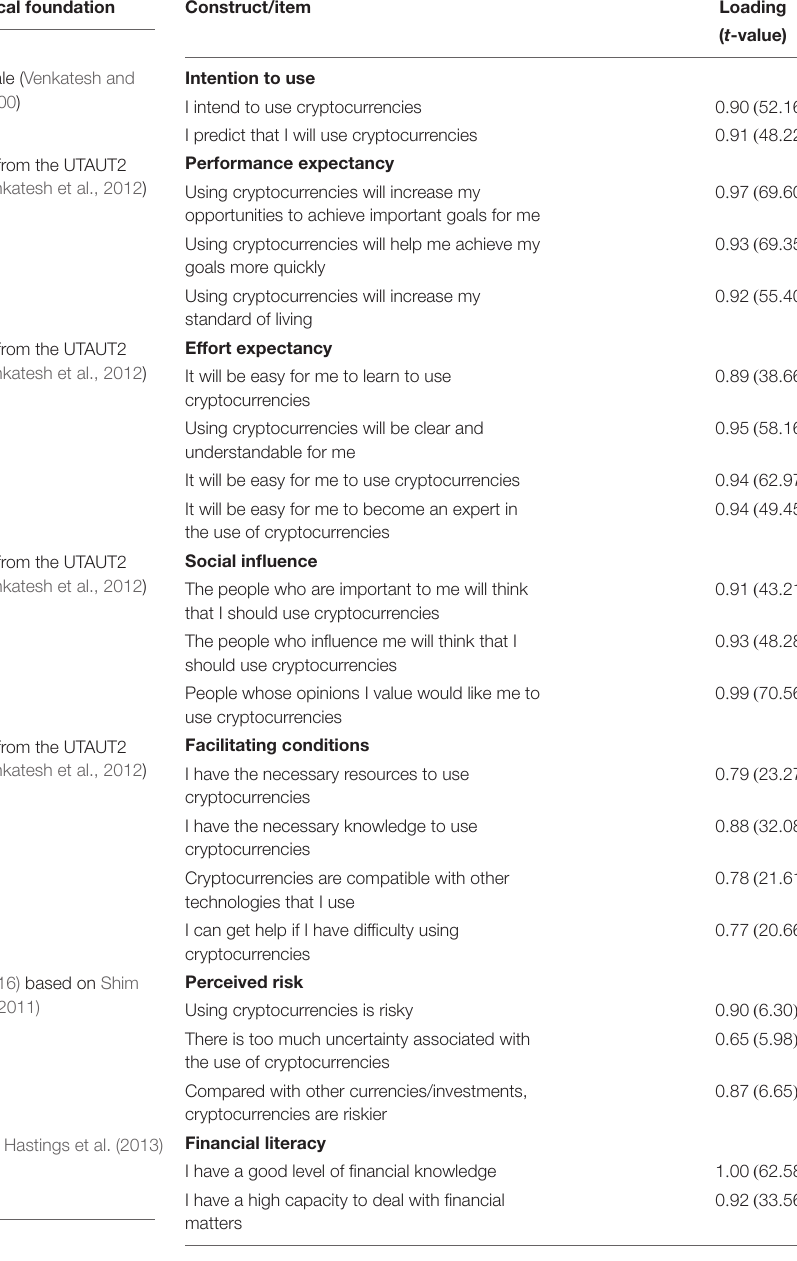
TABLE 1 | Constructs, items, and their theoretical foundations. TABLE 2 | Standardized loadings and t